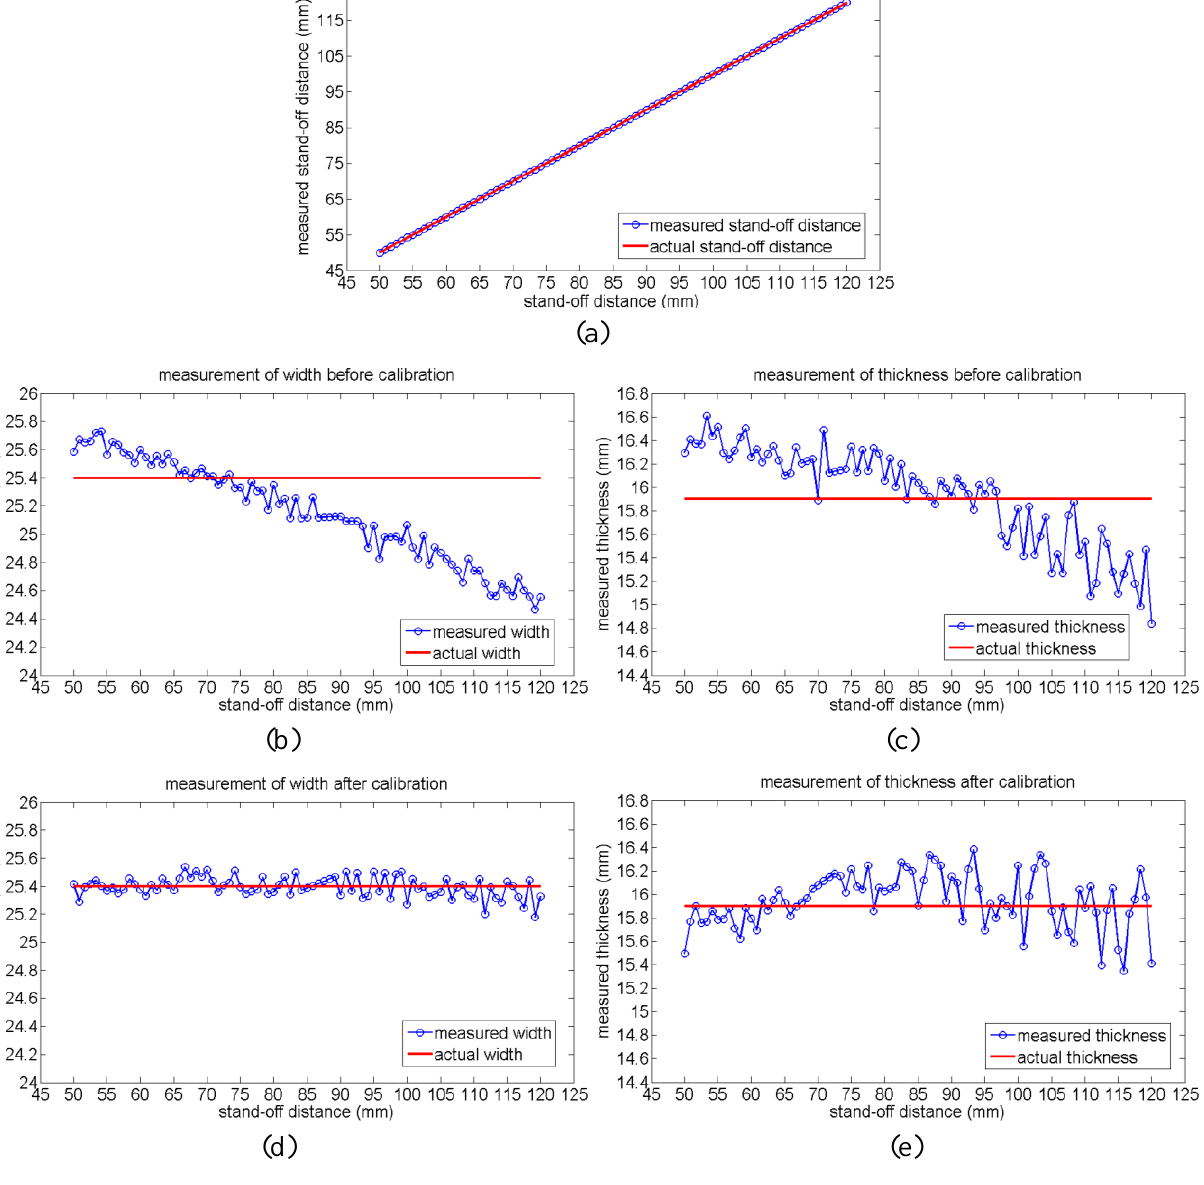
Figure 5. Calibration results of the laser-based vision system: (a) measurement of the stand-off distance before calibration; (b) measurement of the width before calibration; (c) measurement of the thickness before calibration; (d) measurement of the width after calibration; (e) measurement of the thickness after